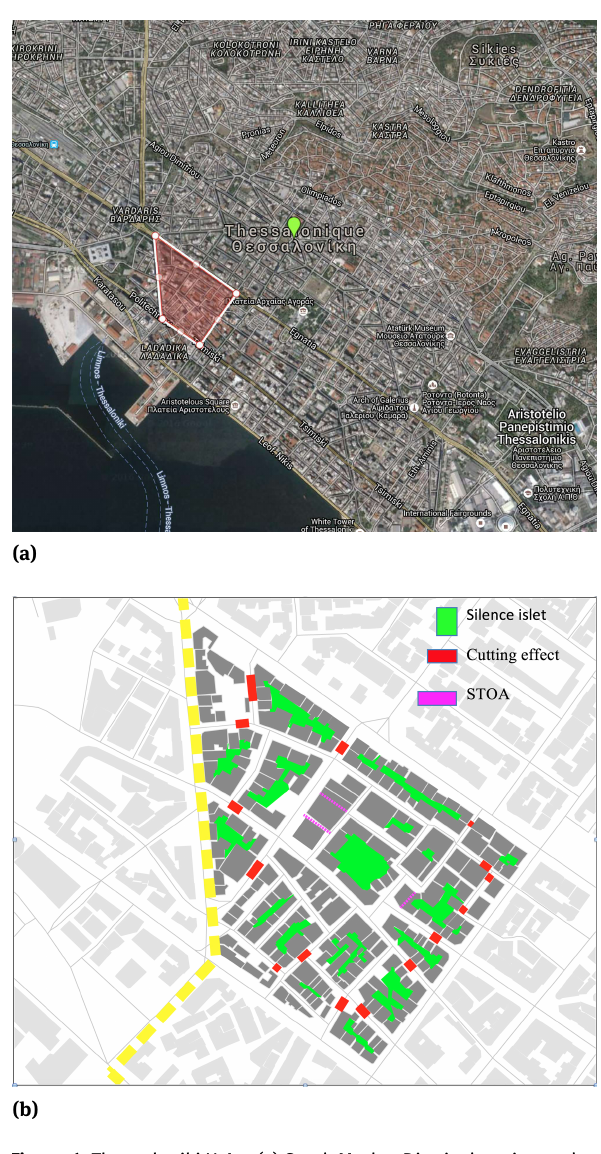
Figure 6: Thessaloniki U.A. : (a) Stock Market District location and (b) Spatio-acoustic effect typology map., 2015 ( e.g. covered walk-